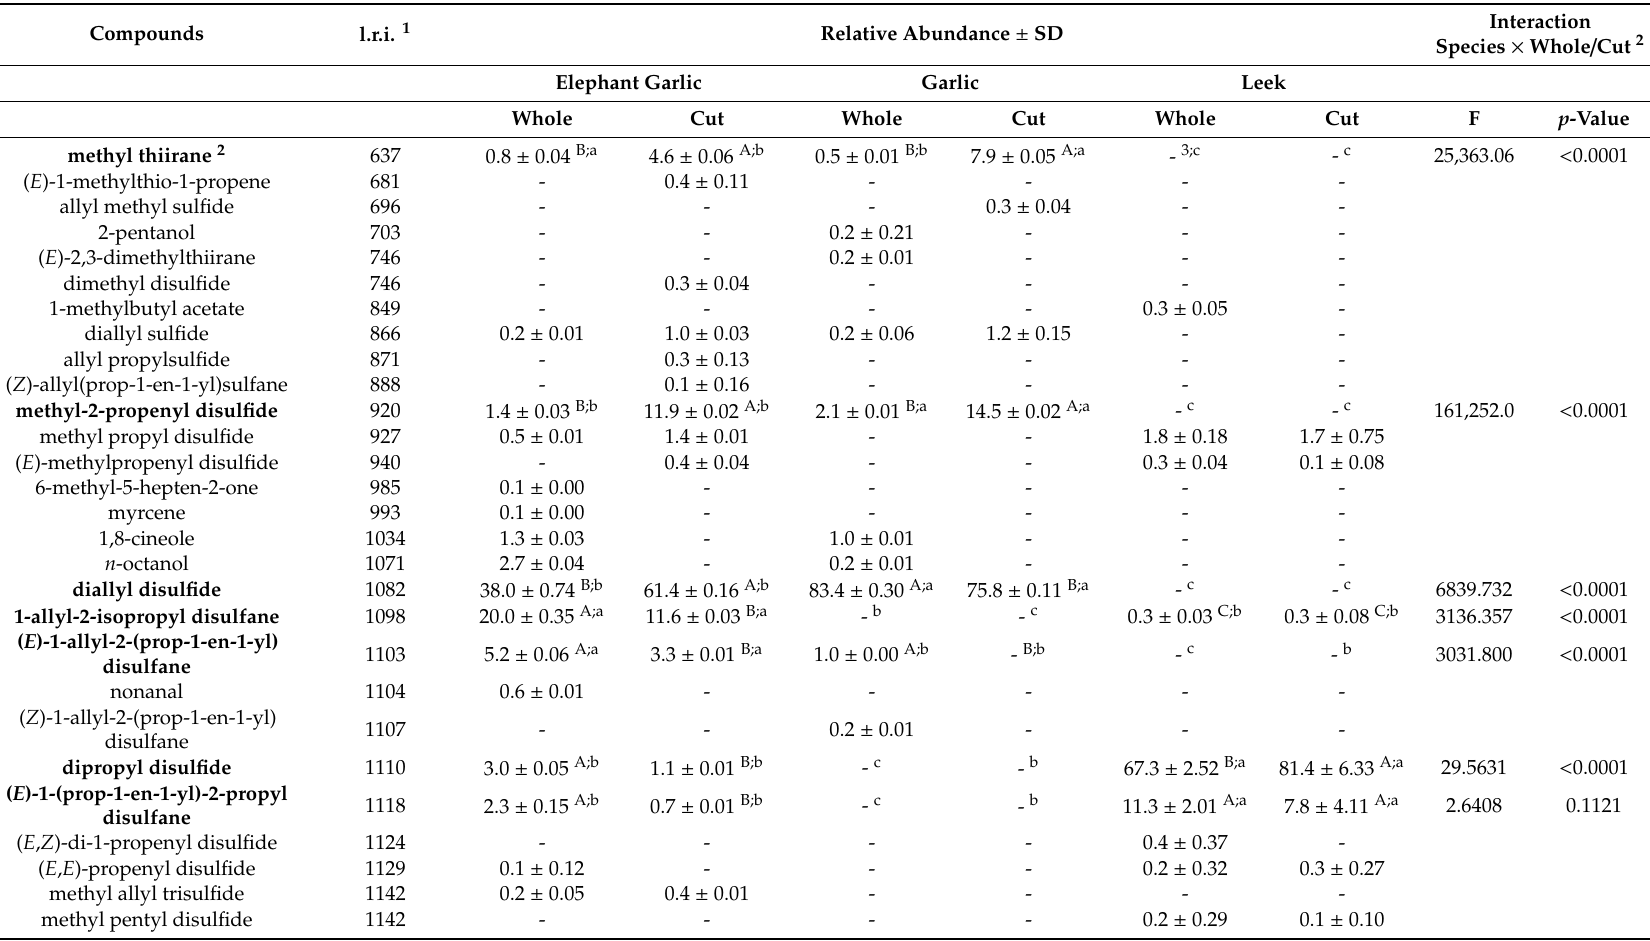
Table 1. Complete compositions of the headspaces of both whole and cut samples of elephant garlic ( Allium ampeloprasum var. holmense (Mill.) Asch. et Graebn), garlic ( A. sativum L.) and leek ( A. ampeloprasum